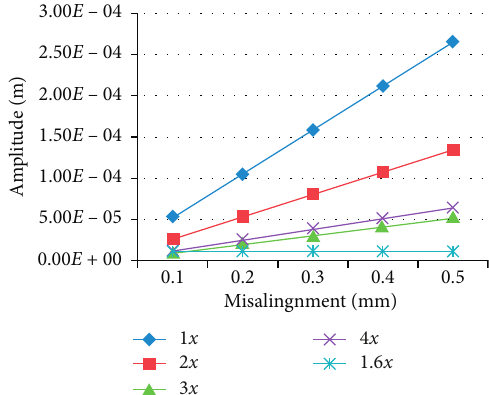
Figure 14: Amplitude of harmonic frequencies altering with